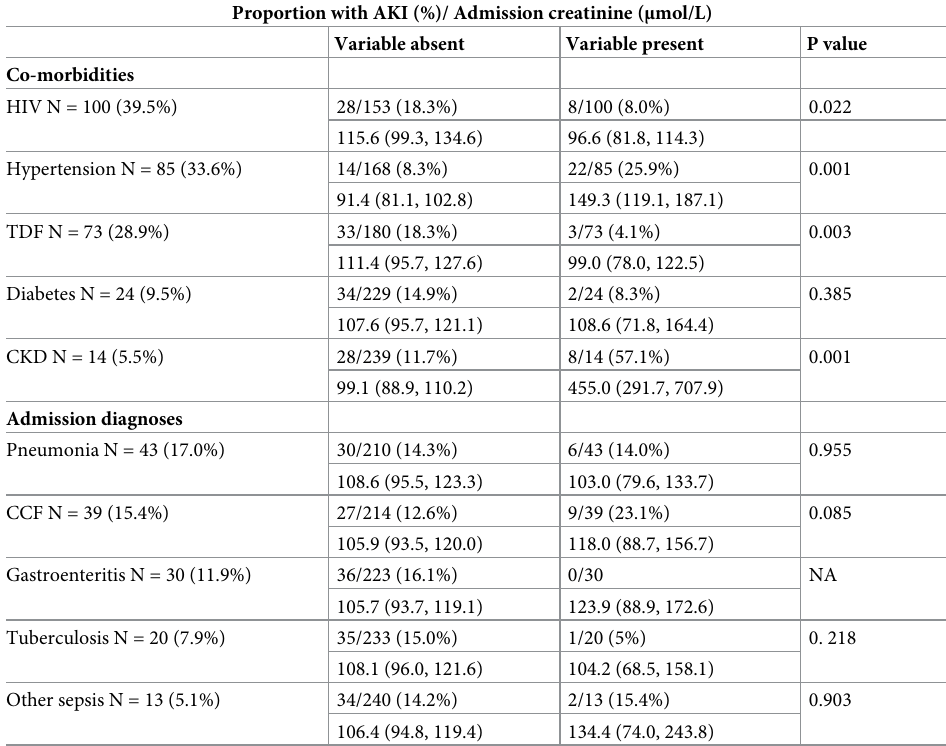
Table 2. AKI and admission creatinine, by comorbidities and admission diagnoses. Proportion with AKI (%)/ Admission creatinine ( μ